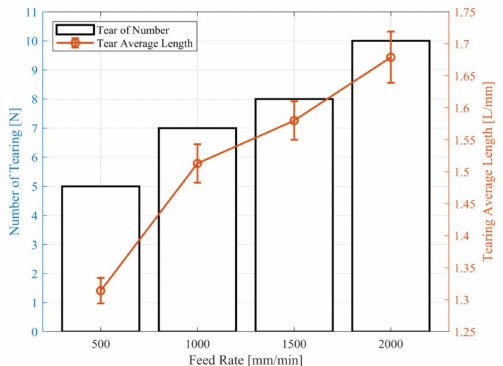
Figure 18. The effect of tool feed rate on surface